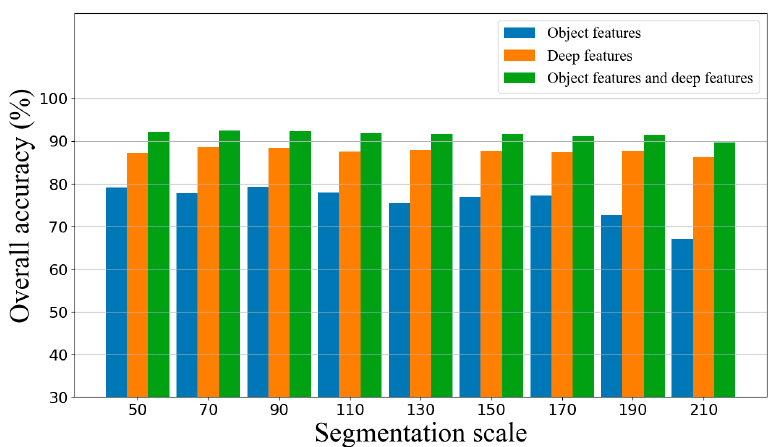
Figure 19. Overall accuracies of di ff erent features combinations.